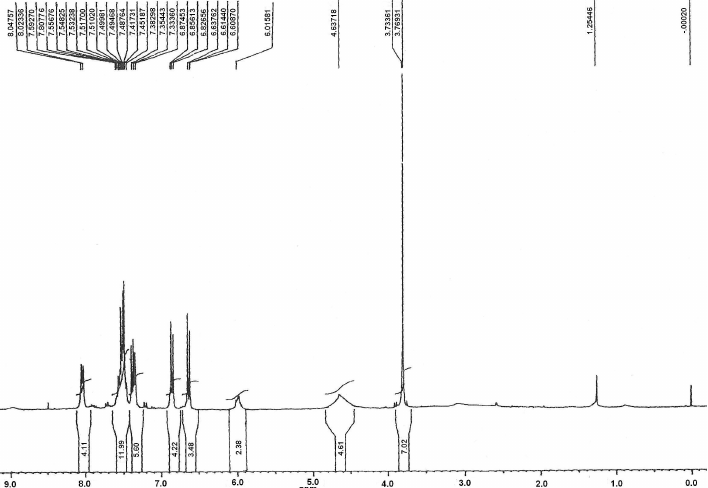
Figure 2. NMR spectra of 3-(4-amino phenyl)-5-(4-methoxybenzylidene-2-phenyl-3, 5- dihydro-imidazol-4-one)